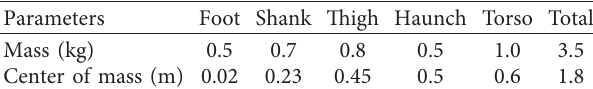
Figure 4: The simulated bipedal robot on the moving vehicle. Table 1: The parameters of the bipedal robot